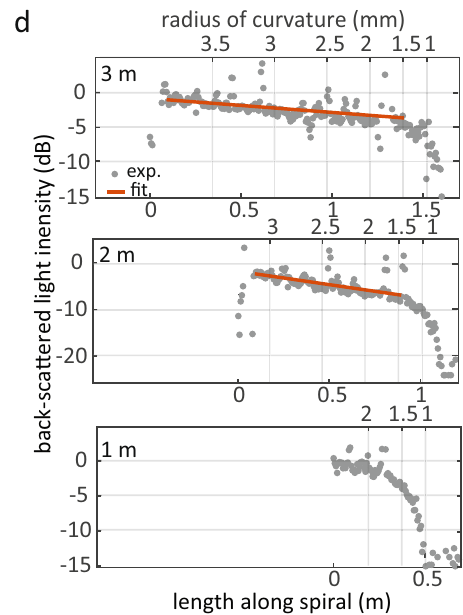
Fig. 2 | Characertization of losses in ultra low-loss waveguide. a Photograph of an ULLW spiral with 1m length under test. Scale bar: 5mm. b Schematic of the Archimedean spirals used for loss measurement, composed of inward (green) and outward (blue) spirals, connected by an S-bend (red). In the measurement, laser light is injected into the spiral, and guided back-scattered photons originating alongthespiral,collectedfromthespiralinput,aredetectedintime-domainwitha resolution of ≈ 200ps. c Radius of curvature (RoC) as a function of length for the